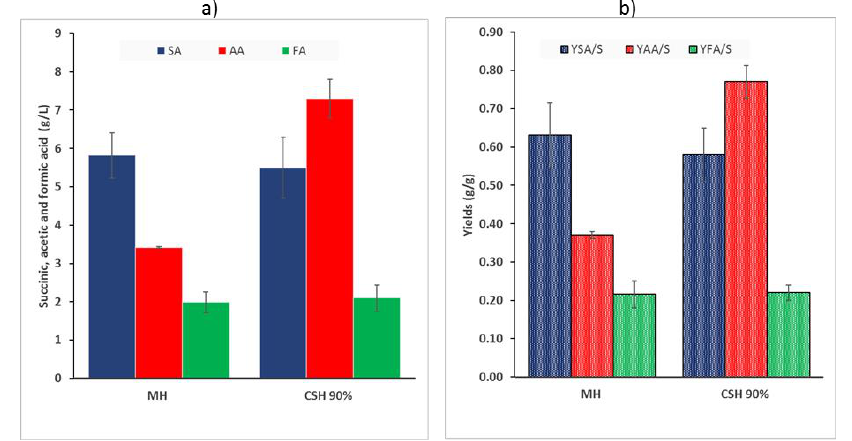
Figure 2. ( a ) Final concentrations of acids produced during growth of A. succinogenes in 0.1 L bottles and ( b ) yields. The strain was grown on the semidefined MH medium containing glucose (7 ± 1 g / L), and xylose (2.0 ± 0.5 g / L) as carbon sources, and on chestnut shells (CSH) hydrolysate (90% v / v ). Data represent mean and standard deviation of at least 3 replicates. Y SA / S , Y AA / S and Y FA / S indicate the g of succinic acid, acetic acid and formic acid, respectively, produced per g of glucose and xylose consumed. SA, succinic acid; AA, acetic acid; FA, formic acid.